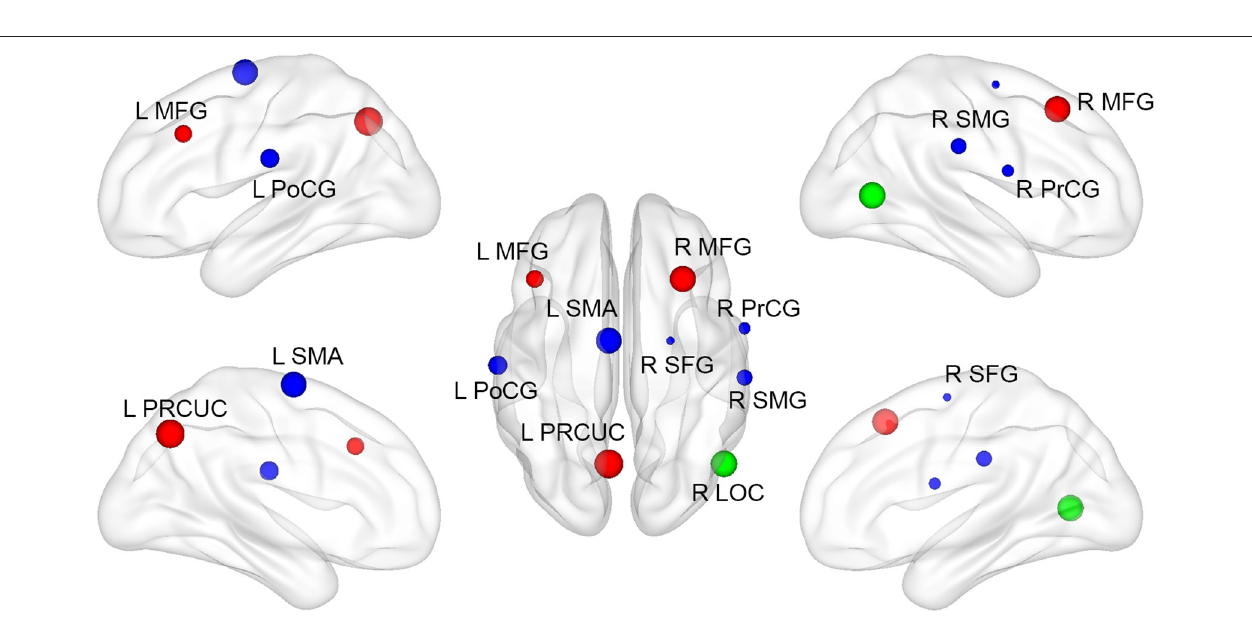
FIGURE 3 | Significant associations between degree and upper extremity motor performance were discovered in R LOC in the right-sided stroke patients. (A) Baseline FMA_UE scores significantly correlated to local degree in R LOC; (B) rFMA_UE significantly correlated to local degree in R LOC.